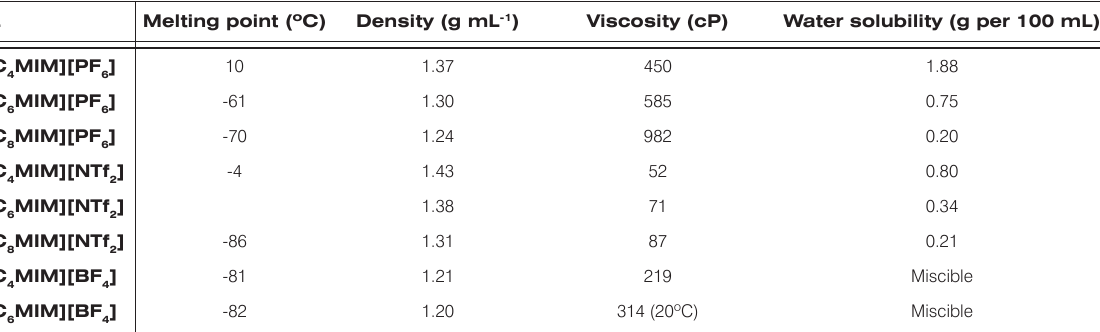
Table 1. Some physicochemical properties of the ILs most commonly used in microextraction (25ºC unless indicated otherwise) [9,17].